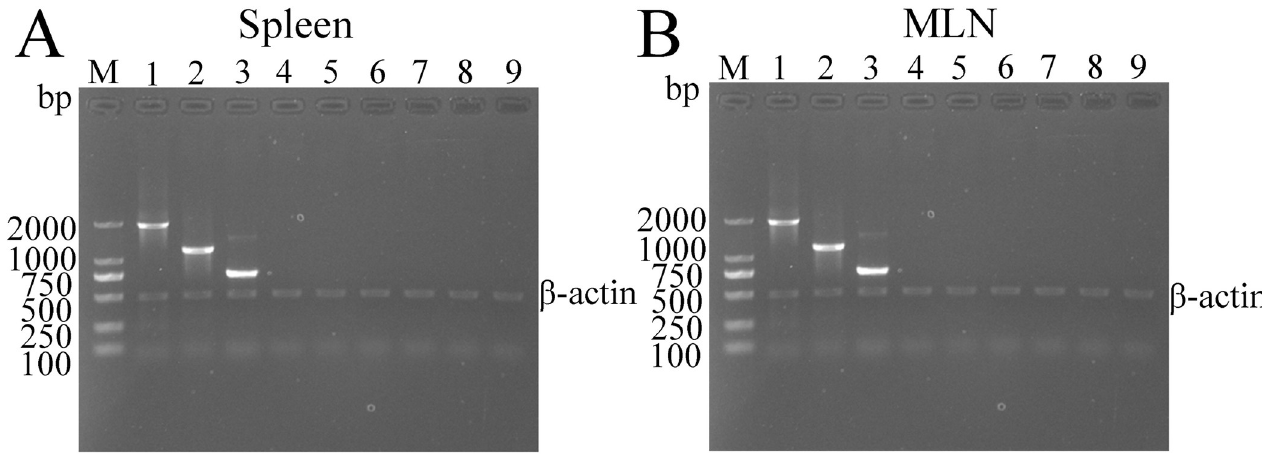
Fig 5. The in vivo transcription of TsCRT+TsSP1.1, TsCRT and TsSP1.1 in spleen (A) and MLN (B) of immunized mice were analyzed by RT-PCR. Lane M: DNA markers; Lane 1: TsCRT+TsSP1.1 immunized murine RNAs amplified by TsCRT+TsSP1.1 primers. Lane 2: TsCRT immunized murine RNAs amplified by TsCRT primer. Lane 3: TsSP1.1 immunized murine RNAs amplified by TsSP1.1 primer. Lane 4: pcDNA3.1 immunized murine RNAs amplified by TsCRT+TsSP1.1 primers. Lane 5: pcDNA3.1 immunized murine RNAs by TsCRT primer. Lane 6: pcDNA3.1 immunized murine RNAs by TsSP1.1 primer. Lane 7: PBS inoculated murine RNAs amplified by TsCRT+TsSP1.1 primers. Lane 8: PBS inoculated murine RNAs by TsCRT primer. Lane 9: PBS inoculated murine RNAs by TsSP1.1 primer.